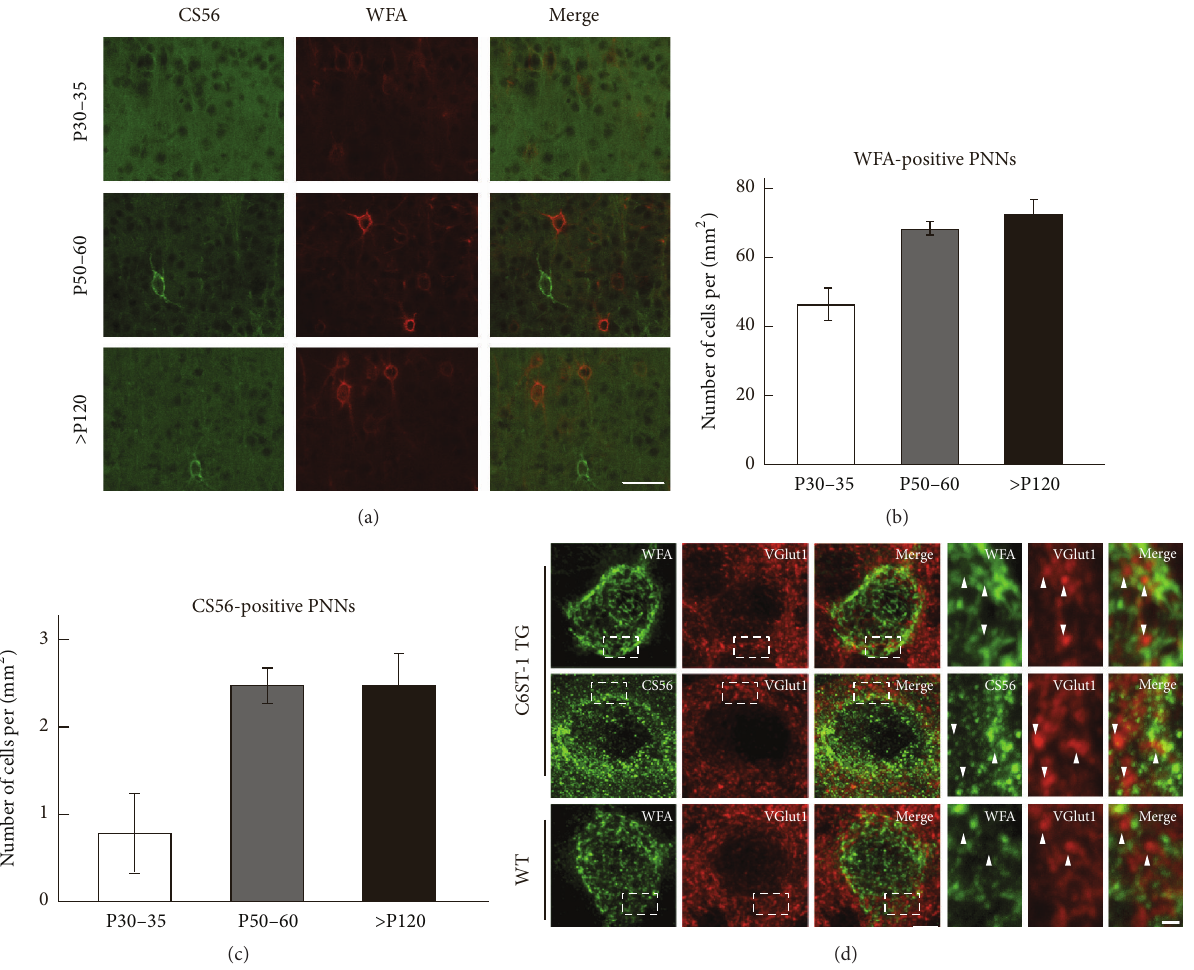
Figure 4: Developmental formation and morphological features of WFA-positive and CS56-positive PNNs. (a) Formation of WFA-positive and CS56-positive PNNs in the cerebral cortex of C6ST-1 TG mice during development. Note that CS56-positive PNNs were not colocalized with conventional WFA-positive PNNs. The numbers of both WFA-positive (b) and CS56-positive PNNs (c) increased until P60 and were maintained in aged C6ST-1 TG mice. Error bars represent SEM; 𝑛 = 2 -3. (d) Three-dimensional reconstruction revealed a distinct lattice-like structure of WFA-positive PNNs in both 6-month-old adult WT and C6ST-1 TG mice. In contrast, CS56-positive PNNs in C6ST-1 mice were sparse dot-like structures. Right: magnification of boxed regions in the left panels. VGluT1-labeled presynaptic terminals (arrowheads) were embedded in the meshwork of WFA-positive PNNs, whereas these terminals were not tightly surrounded by CS56-positive PNNs in C6ST-1 mice. Scale bars represent 50 𝜇 m (a), 5 𝜇 m ((d), left panels), and 1 𝜇 m ((d), right